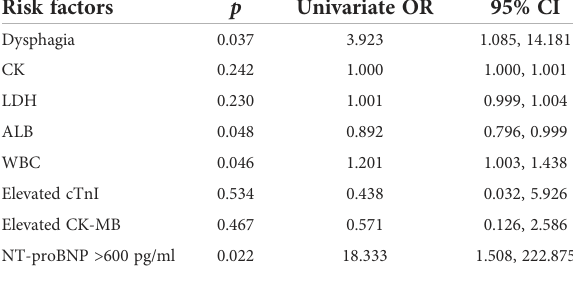
TABLE 4 Logistic regression analysis of associated factors for myocardial involvement of anti-MDA5 Ab+ DM/CADM patients. Risk factors p Univariate